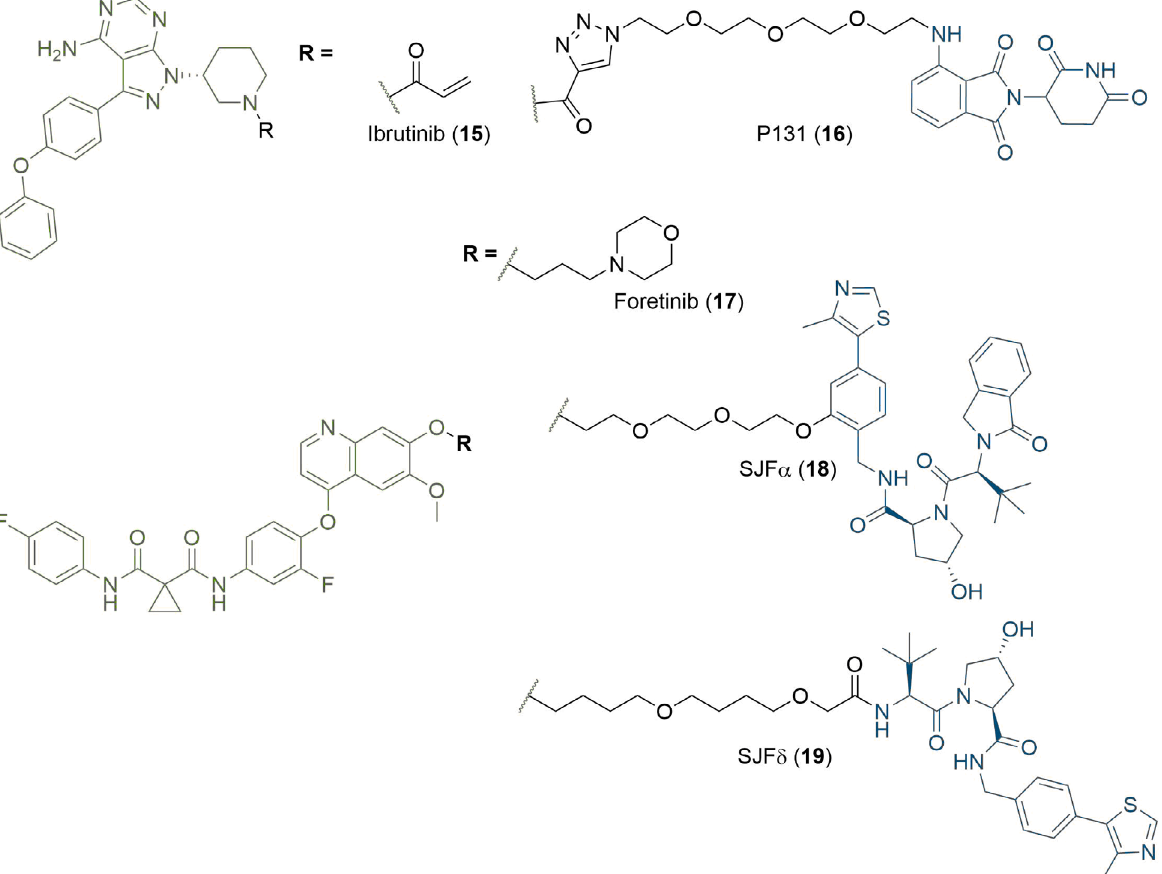
Explor Target Antitumor Ther. 2020;1:273-312 | https://doi.org/10.37349/etat.2020.00018